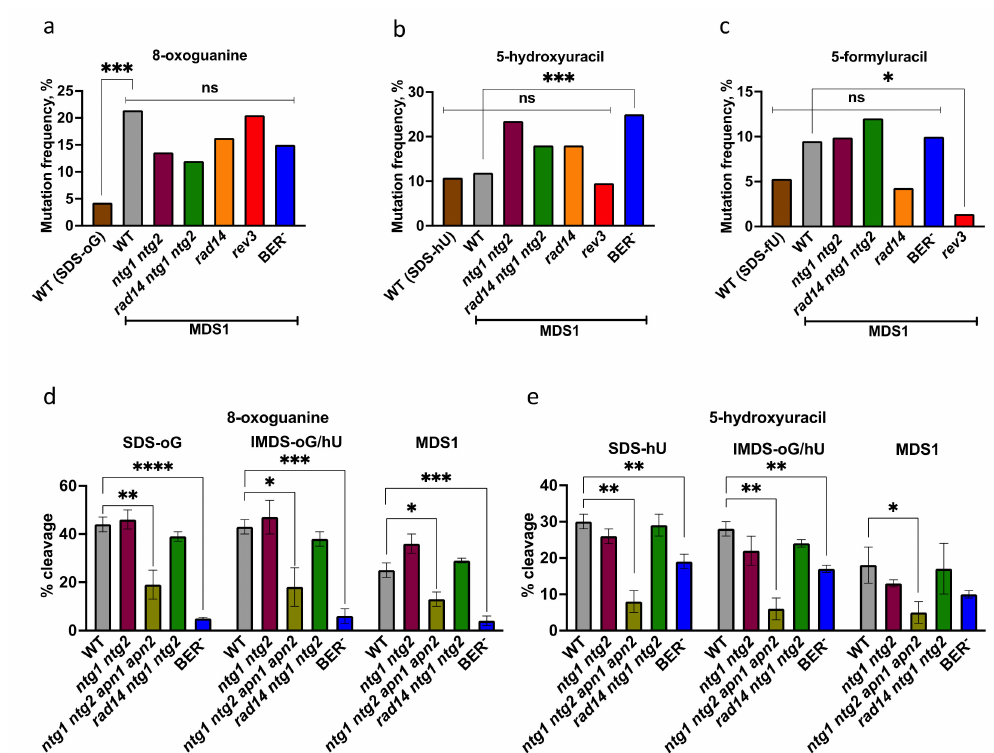
Figure 4. Mutation frequencies at MDS1 in DNA repair-deficient yeast strains and cleavage at damaged sites by yeast whole-cell extract. ( a ) The mutation frequencies observed at 8-oxoguanine in MDS1 in the various strains do not significantly differ (Fisher’s exact test). ( b ) The mutation frequencies observed at 5-hydroxyuracil in MDS1 in the repair-deficient strains do not differ from WT, except in BER - strain (BER - vs. WT, Fisher’s exact test, p = 0.042). ( c ) The mutation frequencies observed at 5-formyluracil in MDS1 in the repair-deficient strains do not differ significantly from WT, except in the rev3 strain (Fisher’s exact test, p = 0.039). ( d ) The extent of cleavage at oG within IMDS-oG/hU, MDS1 by the whole-cell extracts from the various yeast strains, after 2 h incubation, is compared to that in SDS-oG. In WT, MDS1 vs. SDS-oG, p < 0.01; in rad14 ntg1 ntg2 , MDS1 vs. SDS-oG, p < 0.01 ( t -test). ( e ) The extent of cleavage at hU within IMDS-oG/hU, MDS1 by the whole-cell extracts from the various yeast strains, after 2 h incubation, is compared to that in SDS-hU. In WT, MDS1 vs. SDS-hU, p < 0.05; in ntg1 ntg2 , MDS1 vs. SDS-hU, p < 0.01; in BER - , MDS1 vs. SDS-hU, p < 0.01 ( t -test). For technical reasons, the cleavage at fU in MDS1 was not studied. Fisher’s exact test or t -test p -values are abbreviated as follows: ****: p < 10 − 4